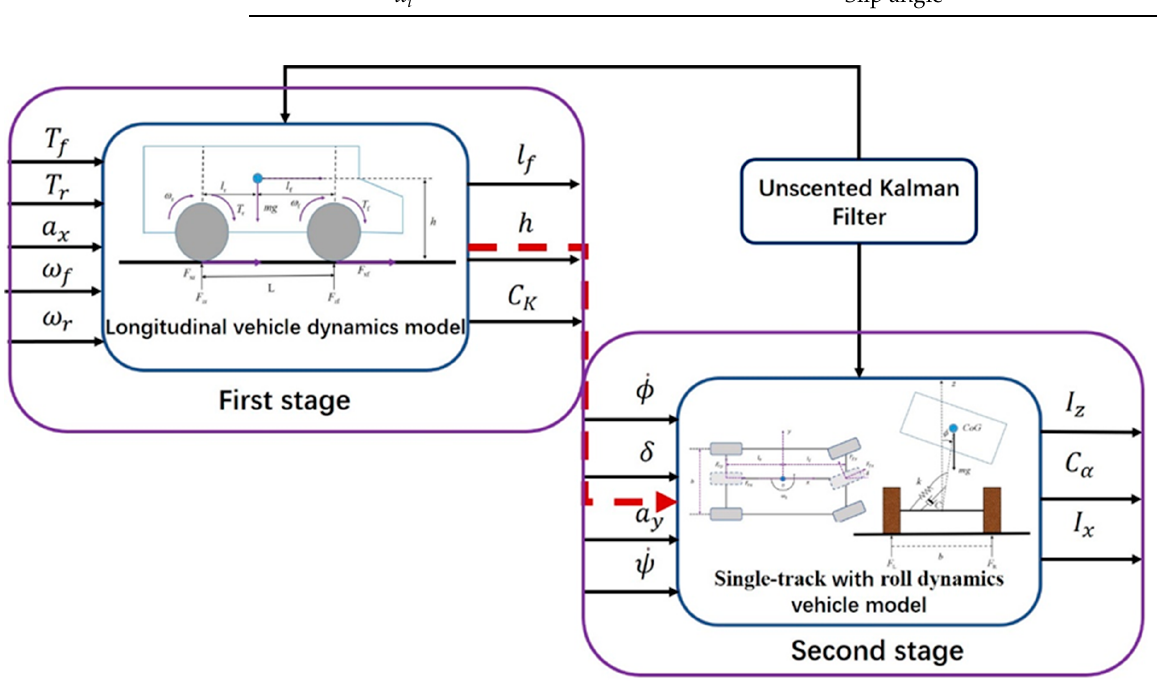
Figure 3. Two ‐ stage estimation method. Figure 3. Two-stage estimation